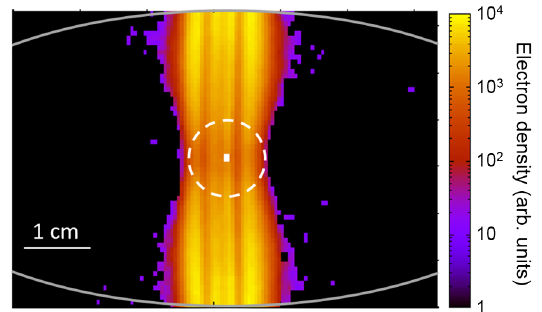
FIG. 5. Electron cloud forms a stripe inside the vacuum chamber; beam center and its 2 - σ boundary are shown in white. Results of a numerical simulation using the PEI